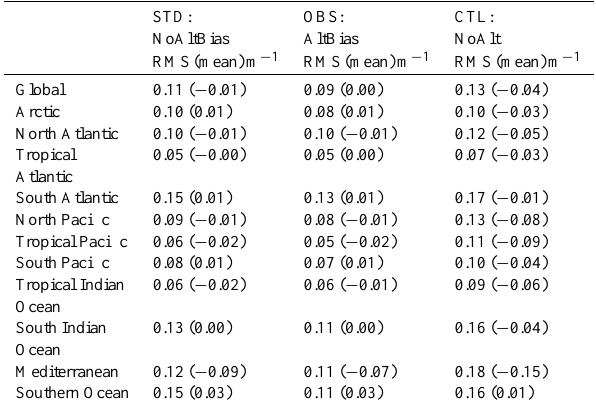
Table 1. Comparison of SSH RMS and mean innovations for global model hindcasts averaged in various regions and over the period 1 February 2008 to 30 April 2008 from the Met Office FOAM